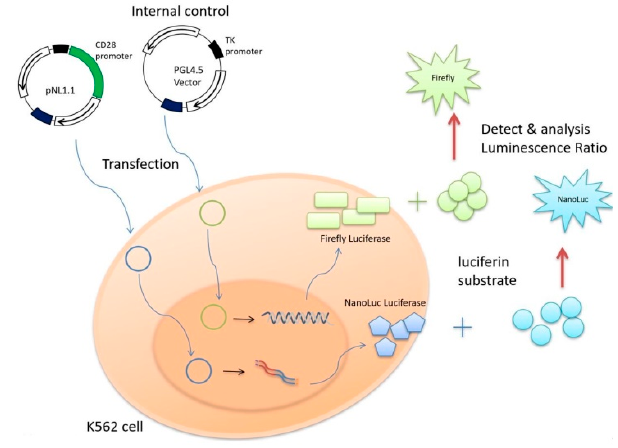
Figure 1. The schematic diagram of luciferase reporter assay.